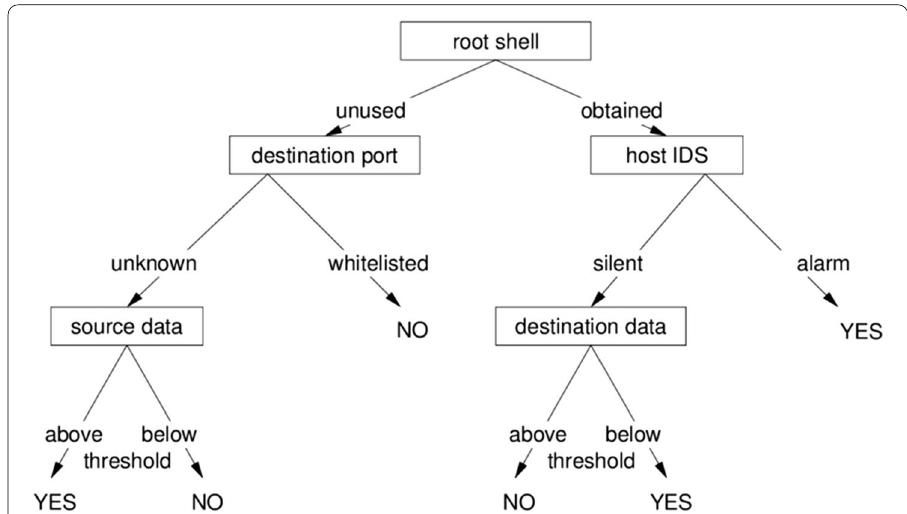
Fig. 2 Sample host based IDS decision